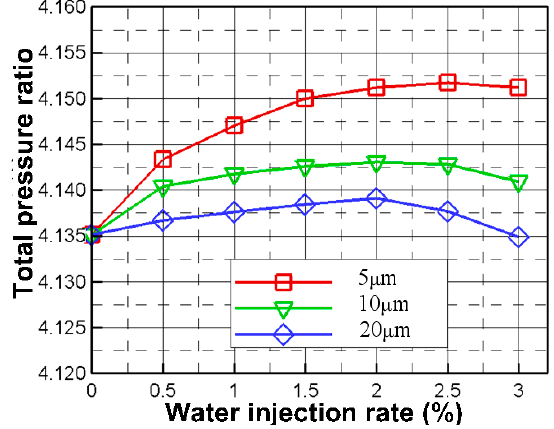
Figure 17. Comparison of total pressure ratio under dry and water injection cases.